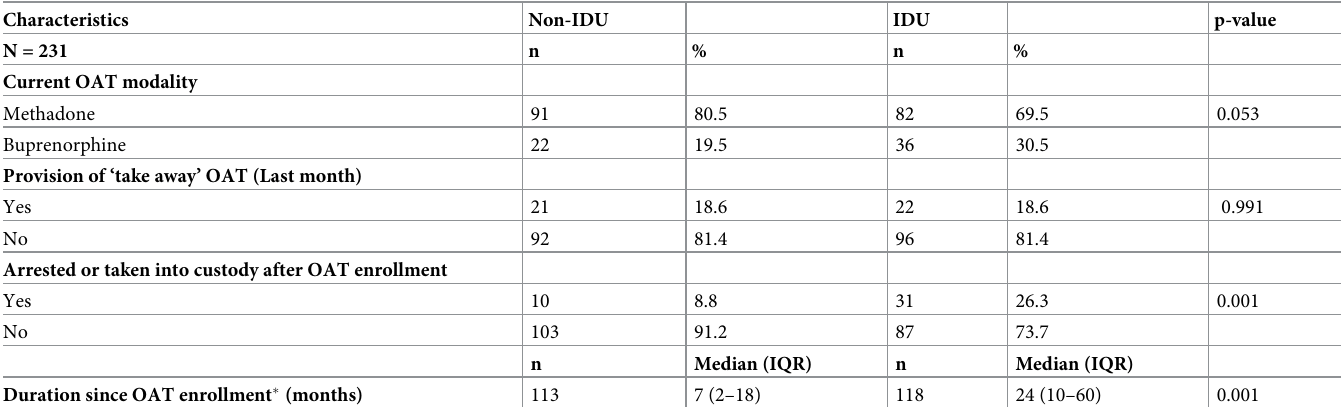
Table 2. Comparison of Opioid Agonist Treatment related characteristics between non-injecting and injecting drug users. Characteristics